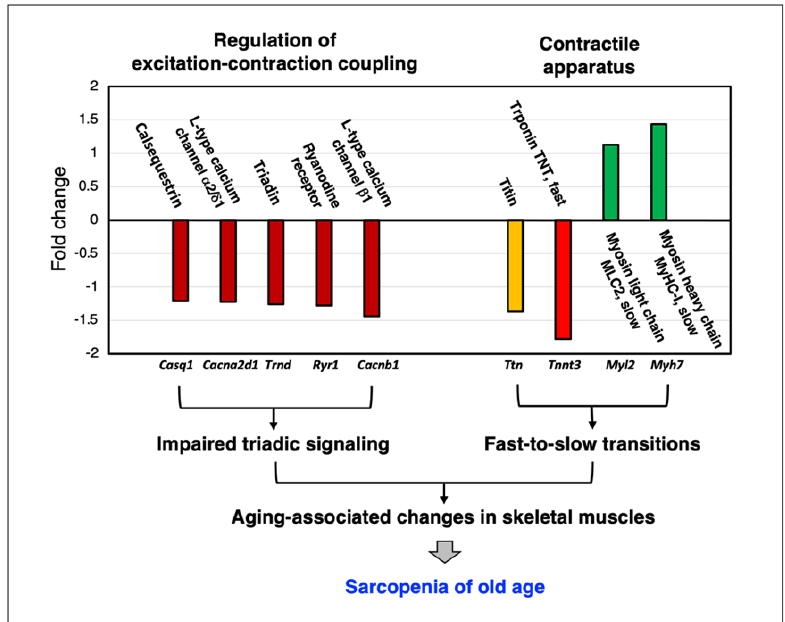
Figure 3. Representative example of the mass-spectrometry-based proteomic analysis of skeletal muscle aging. Shown are crucial regulatory proteins of excitation – contraction coupling and Ca 2+ - homeostasis (dihydropyridine receptor L-type Ca 2+ -channel, ryanodine receptor Ca 2+ -release chan- nel, calsequestrin and triadin) and sarcomeric proteins (titin, troponin, myosin light chain and myosin heavy chain). Mass spectrometric analyses of young versus aged wild-type mouse diaphragm muscle specimens were carried out as previously described in detail [201,269,333].